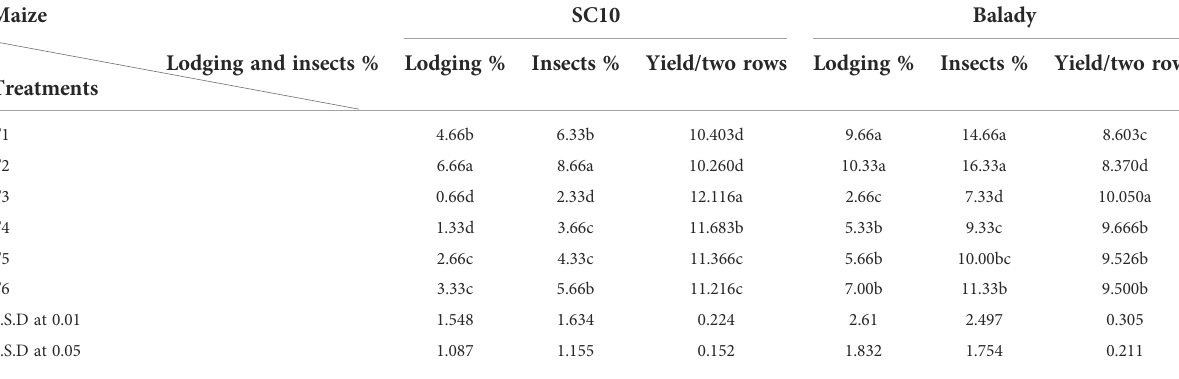
TABLE 10 Percentage of lodging, insect incidence and yield per two rows (kg) under the tested treatments during the 2020 growing season. Maize SC10